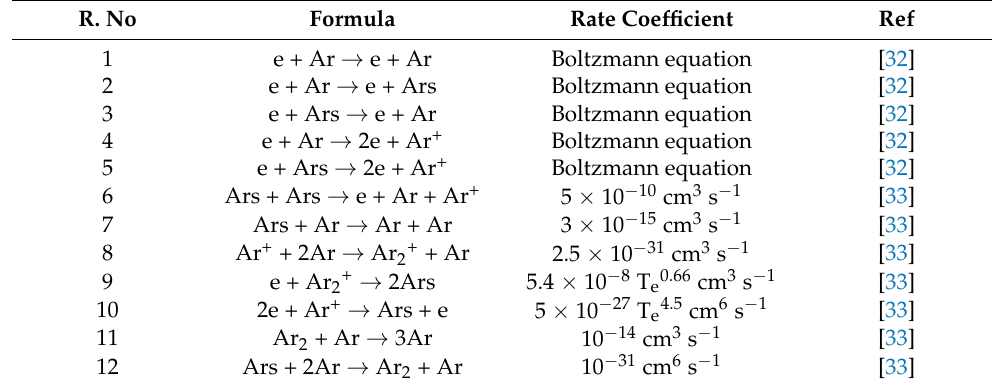
Table 1. Reactions induced in the model along with their rate coefficients.